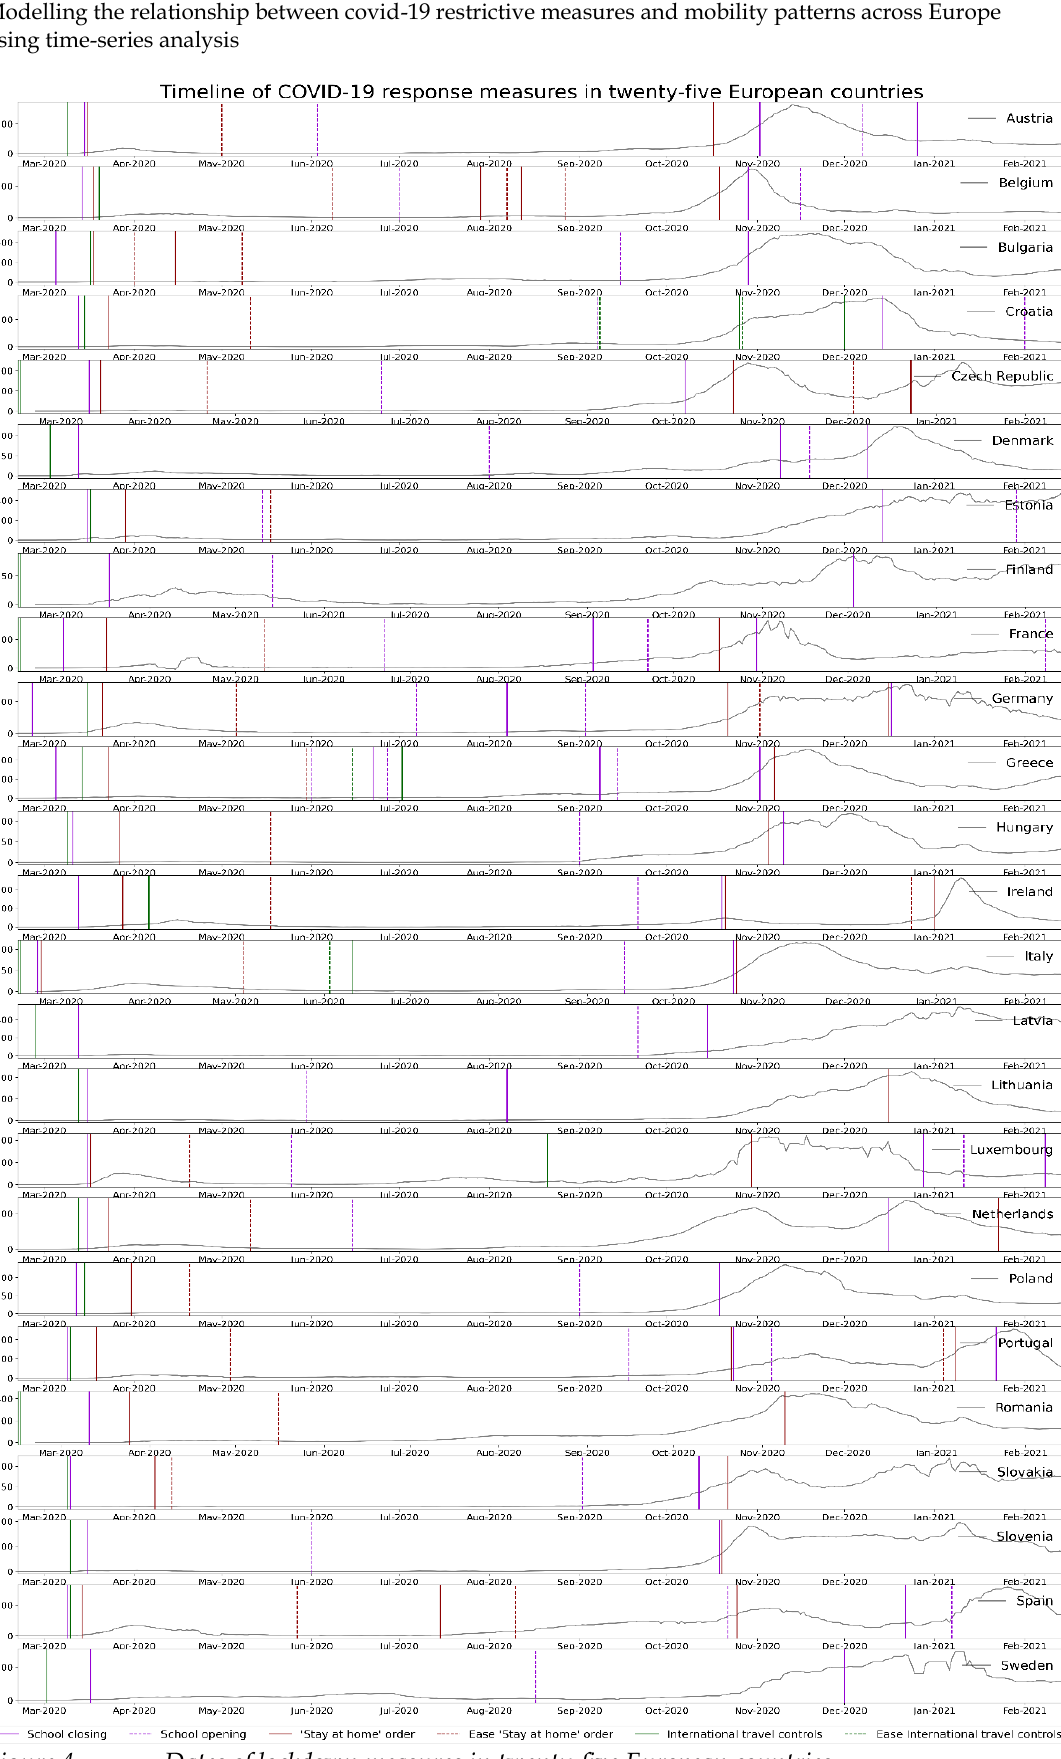
Figure 4. Dates of lockdown measures in twenty-five European